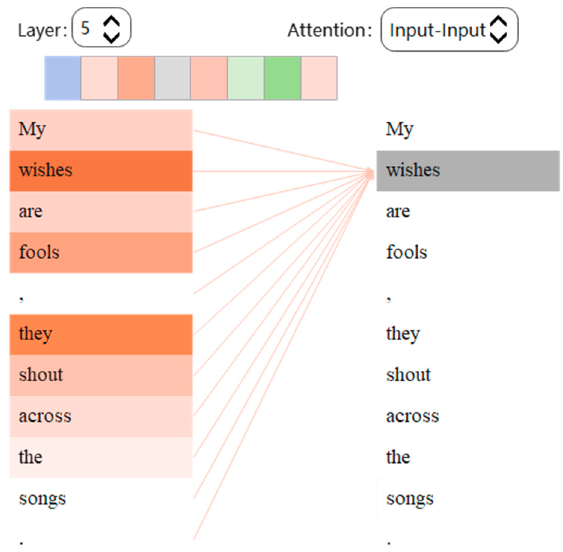
Figure 2. Attention visualization.